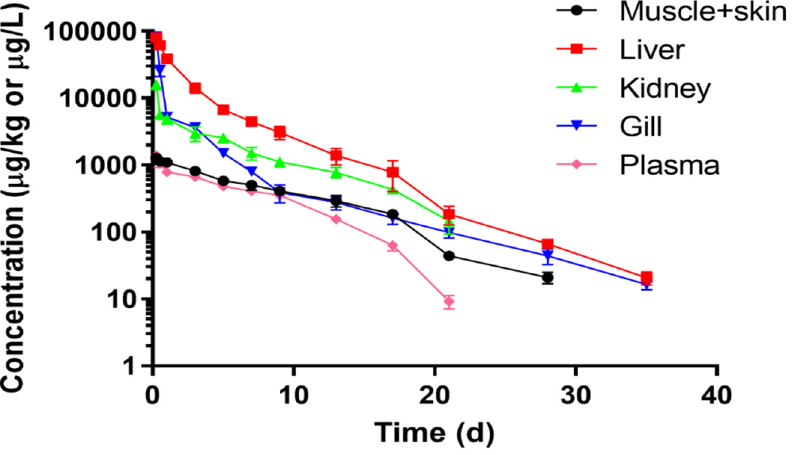
Figure 1. Depletion kinetic curves of doxycycline in plasma and various tissues of yellow catfish ( Pelteobagrus fulvidraco ) after consecutive 3-day oral administrations at 20 mg/kg/day ( n = 6). Table 2. The concentrations of doxycycline in muscle + skin, liver, kidney, gill, and plasma of yellow catfish ( Pelteobagrus